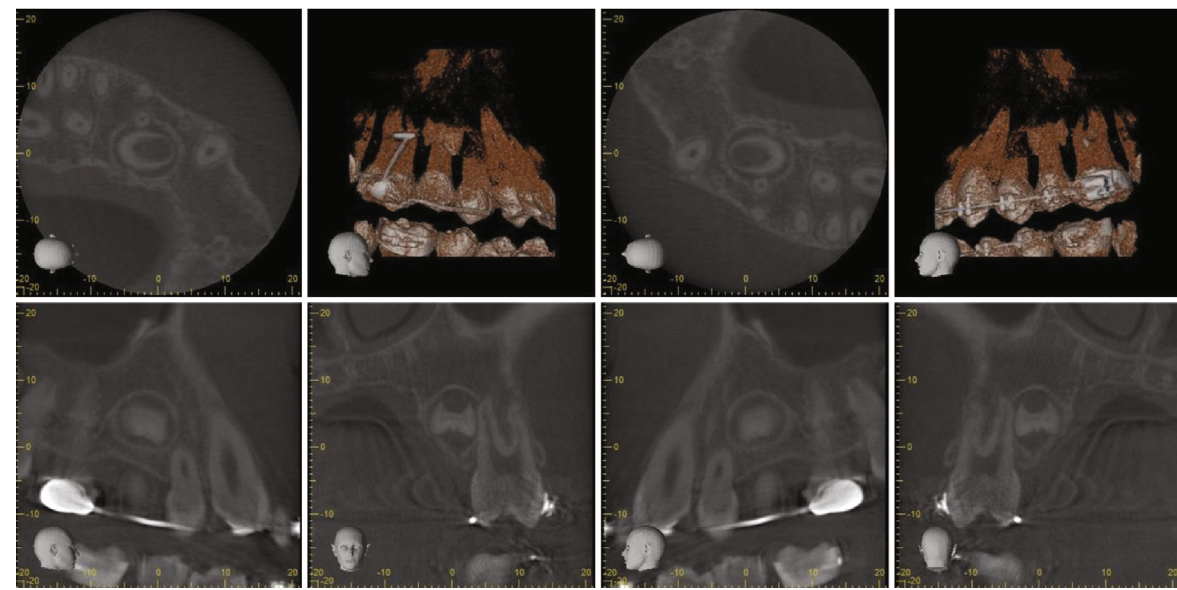
Figure 7: CBCT shows new supernumerary tooth developing in the upper left quadrant.